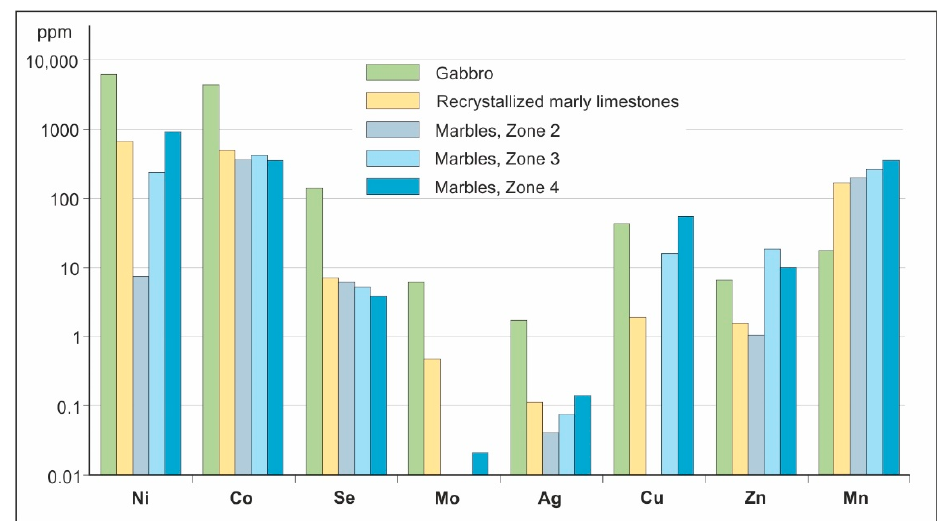
Figure 14. Average trace element compositions of pyrrhotite from gabbro, recrystallized marly limestones, and marbles from the Kochumdek contact aureole; based on LA-ICP-MS data (Table 8).